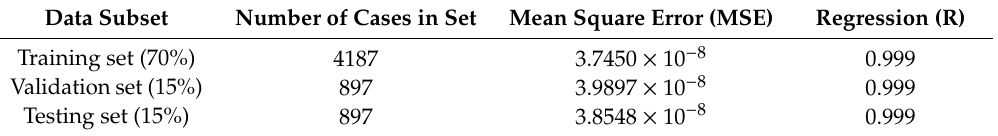
Figure 11. Best validation performance is 3.9897 × 10 − 8 at epoch 20: ( a ) general view, ( b ) enlarged view of the terminal part of the curve.